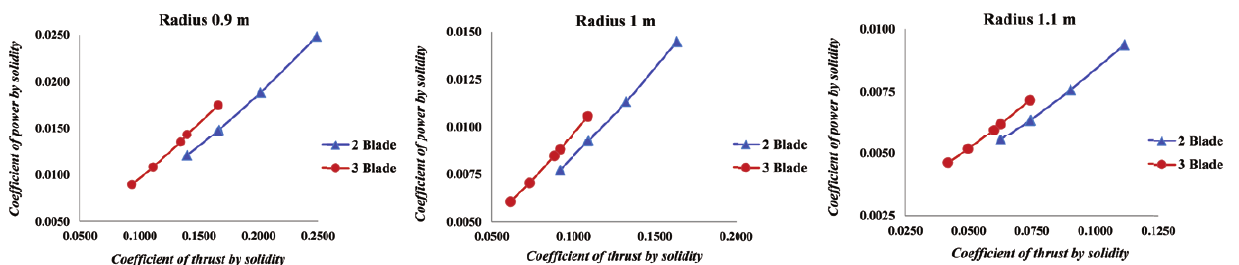
Figure 7. C P / σ versus C T / σ comparison for 2-blade and 3-blade coaxial rotor